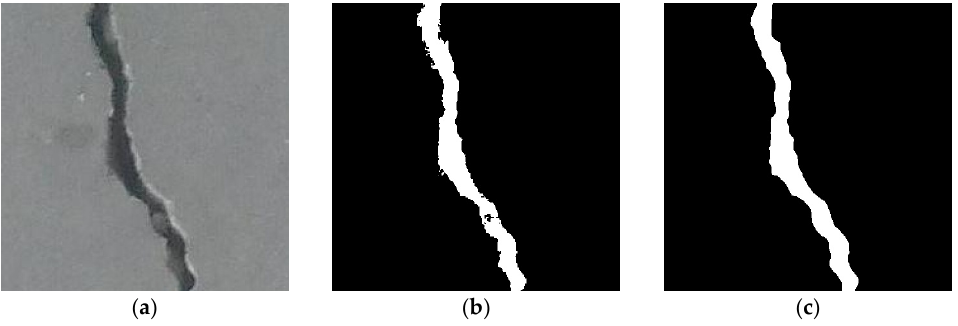
Figure 12. Example of an image with crack: ( a ) original image; ( b ) first-round crack GT; ( c ) second-round crack GT.